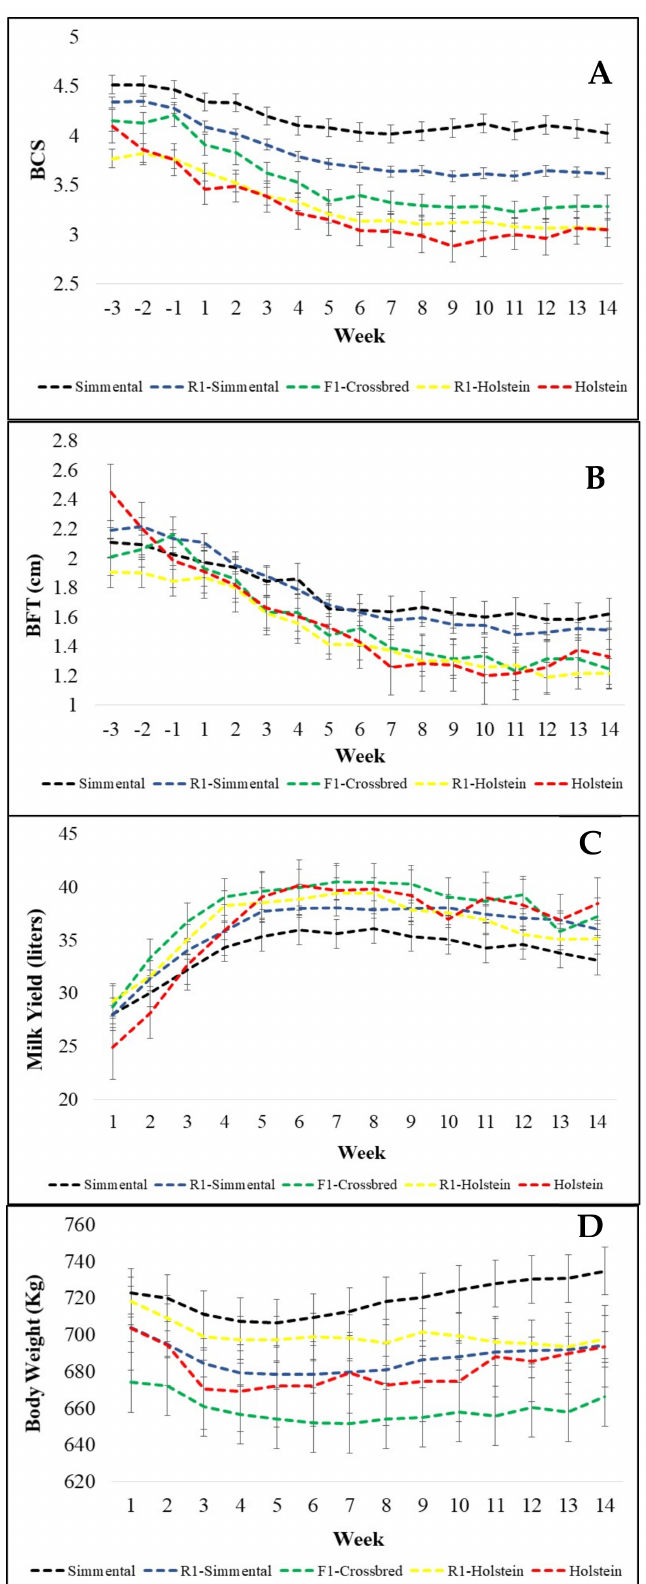
Figure 1. Weekly means of body condition score (BCS) ( A ), back fat thickness (BFT) ( B ), milk yield ( C ), and body weight ( D ) between week three before calving and week fourteen after calving for purebred Holstein, Simmental cows, and their